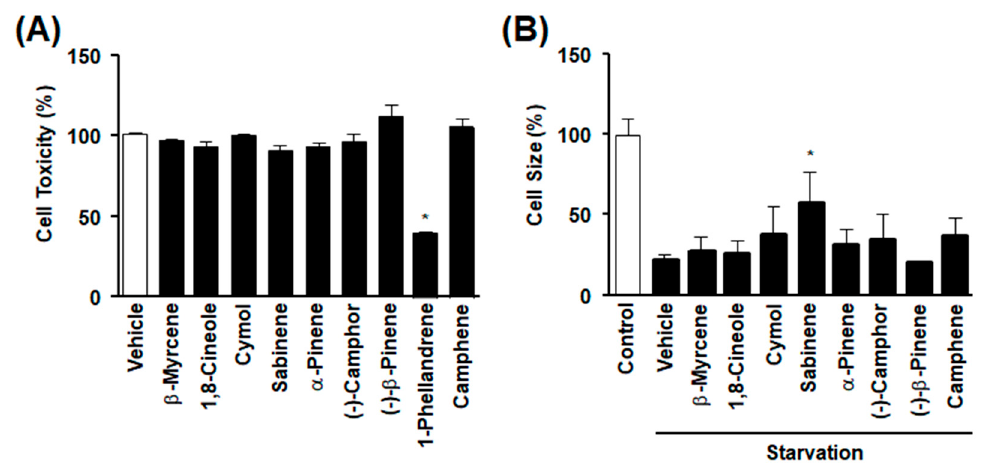
Figure 2. Effects of components identified from Chrysanthemum boreale Makino essential oil on starvation-induced atrophy of L6 cells. ( A ) Effects of components identified from CBMEO on L6 myoblasts’ viabilities. Cells were incubated in the presence or absence of nine components of monoterpenoids identified from CBMEO (300 μ M for each component) for 48 h, and cell viability was measured using an XTT assay. Cellular response in the quiescent state was considered as 100% ( n = 16). * p < 0.05 vs. untreated cells. ( B ) Effects of CBMEO components on starvation-induced atrophy of L6 myoblasts. L6 myoblasts were incubated with serum-free DMEM with or without a component identified from CBMEO for 18 h. Cell size in the quiescent state was considered as 100% ( n = 12). * p < 0.05 vs. starved myoblasts in the absence of a component.